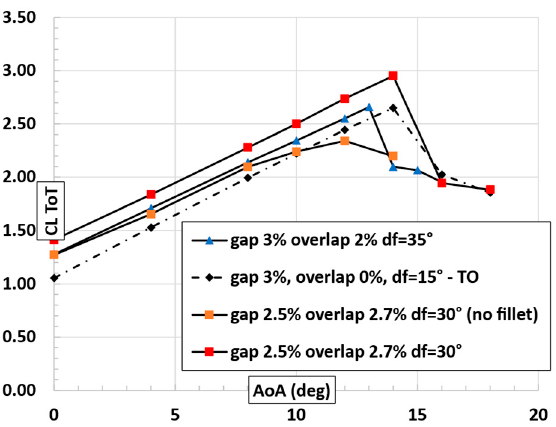
14 deg. ( a ) Geometry without fillet. ( b ) Geometry with fillet.